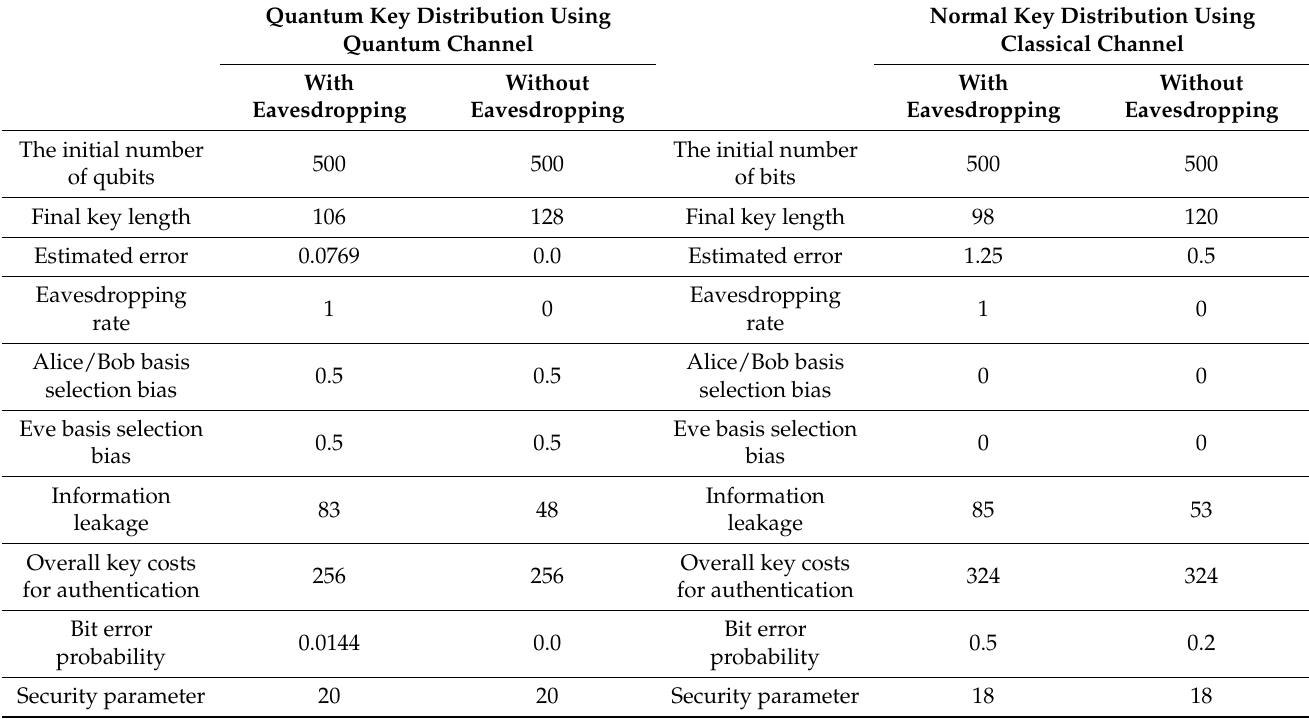
Table 9. Comparison of proposed architecture using quantum channel and normal key distribution using classical